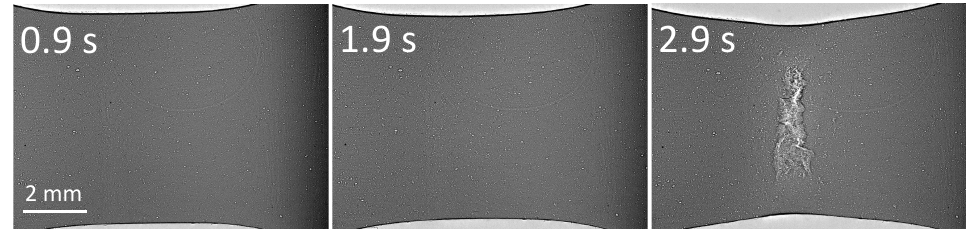
Figure 5. X-ray images of Scalmalloy specimen (printed 0° flat) under tension in quasi-static UTM. Image series captured by Photron SA-Z high speed camera at 10 kHz frame rate and a resolution of 1024 × 1024 pixels. From left to right, different timestamps capturing the formation of voids to fracture. White contrast in these radiographs represent high intensity X-rays. The aspect ratio of the images are adjusted for illustration